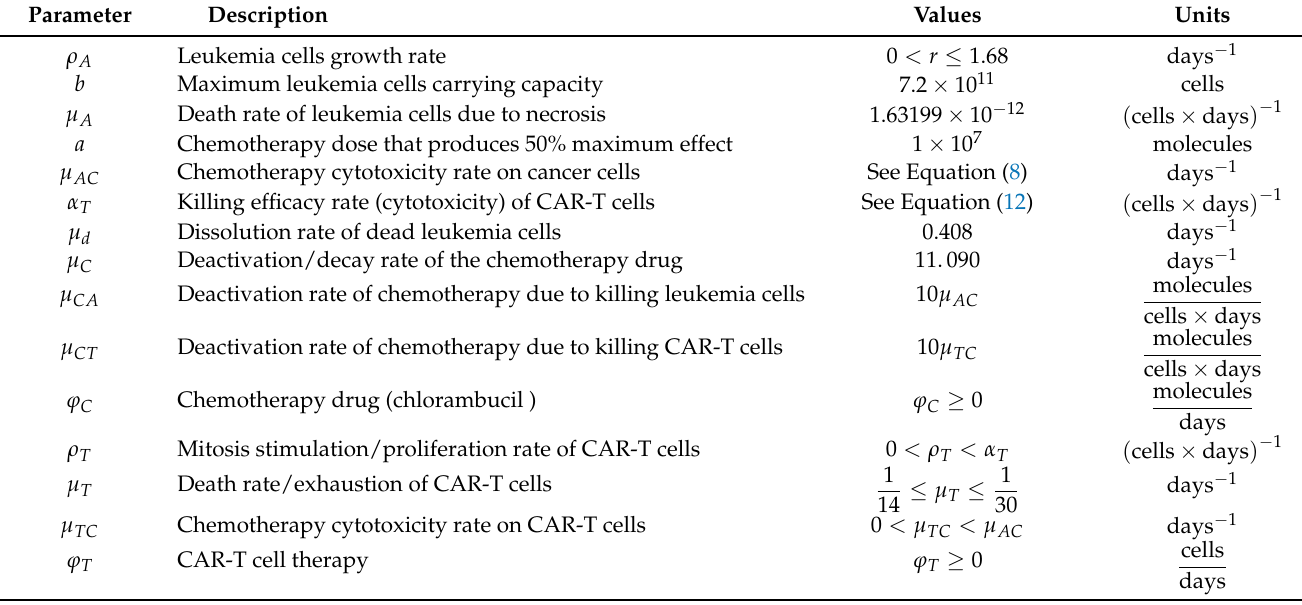
Table 1. Parameter information for the leukemia and chemoimmunotherapy mathematical